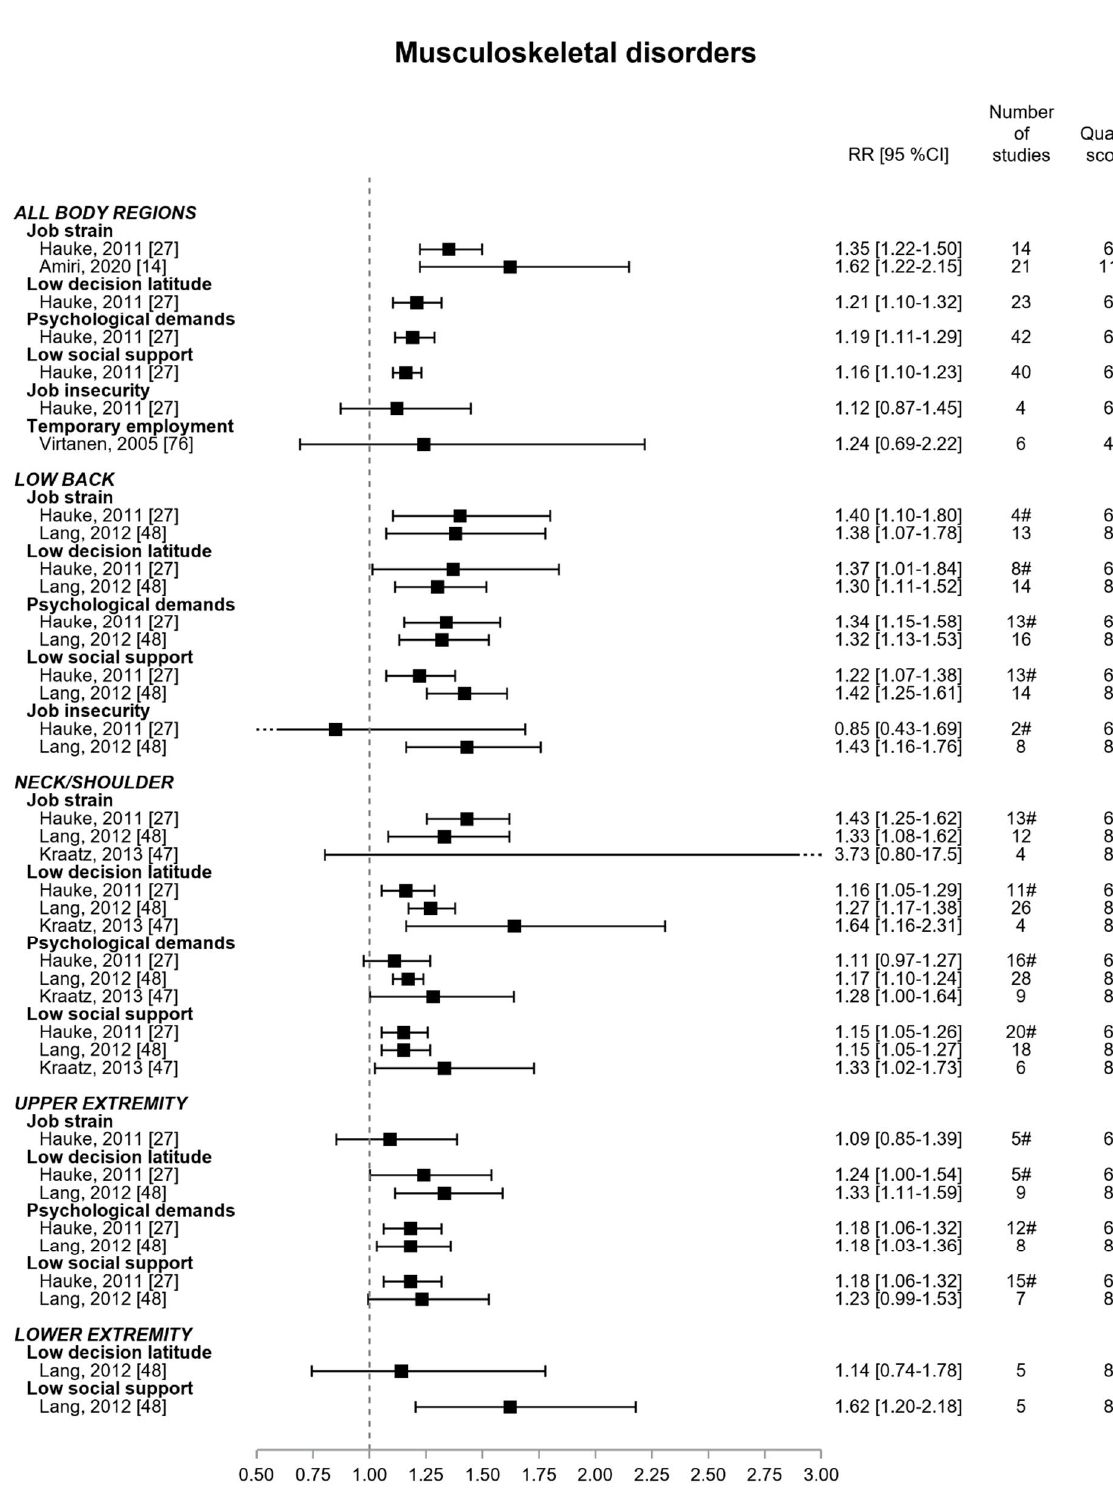
Figure 9. Pooled estimates for the associations between psychosocial work exposures and musculoskeletal disorders. # N of effect